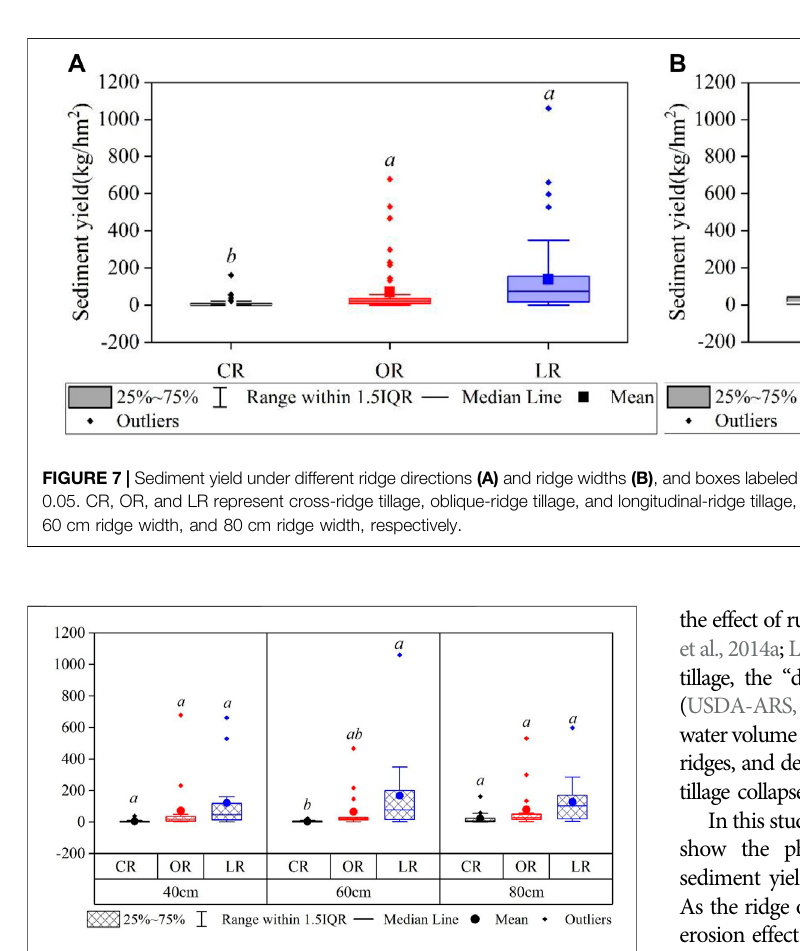
Frontiers in Earth Science |